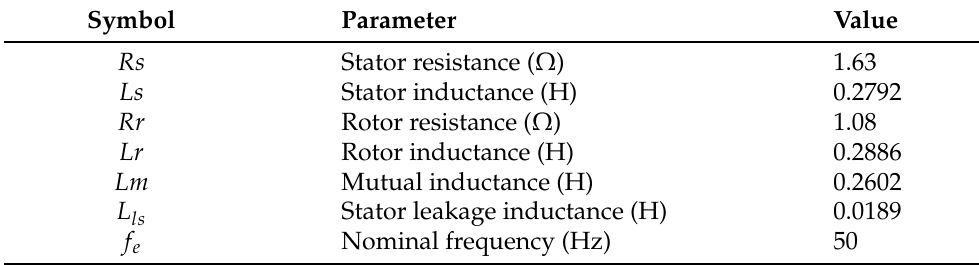
Table 1. Electrical parameters for the experimental motor drive obtained by